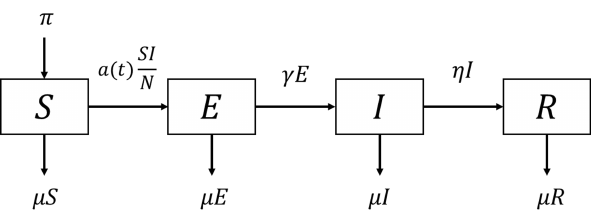
Figure 1. Flow diagram of the simple SEIR model.